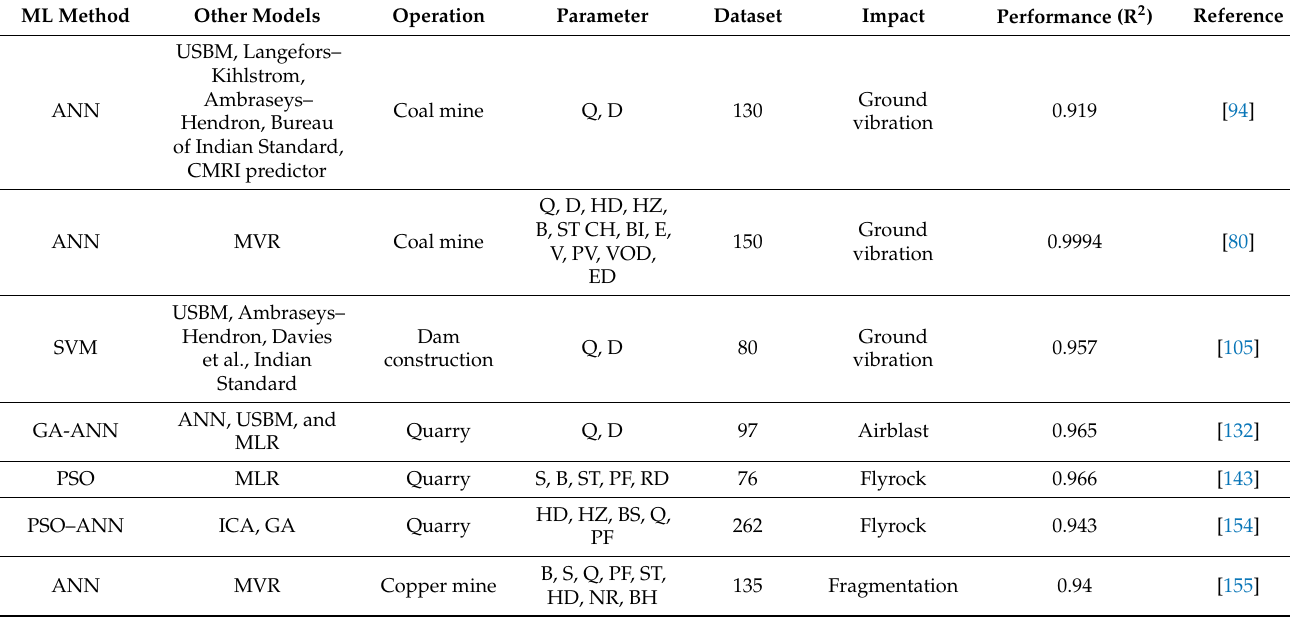
Table 6. Summary of the ML-based blast-induced impact prediction